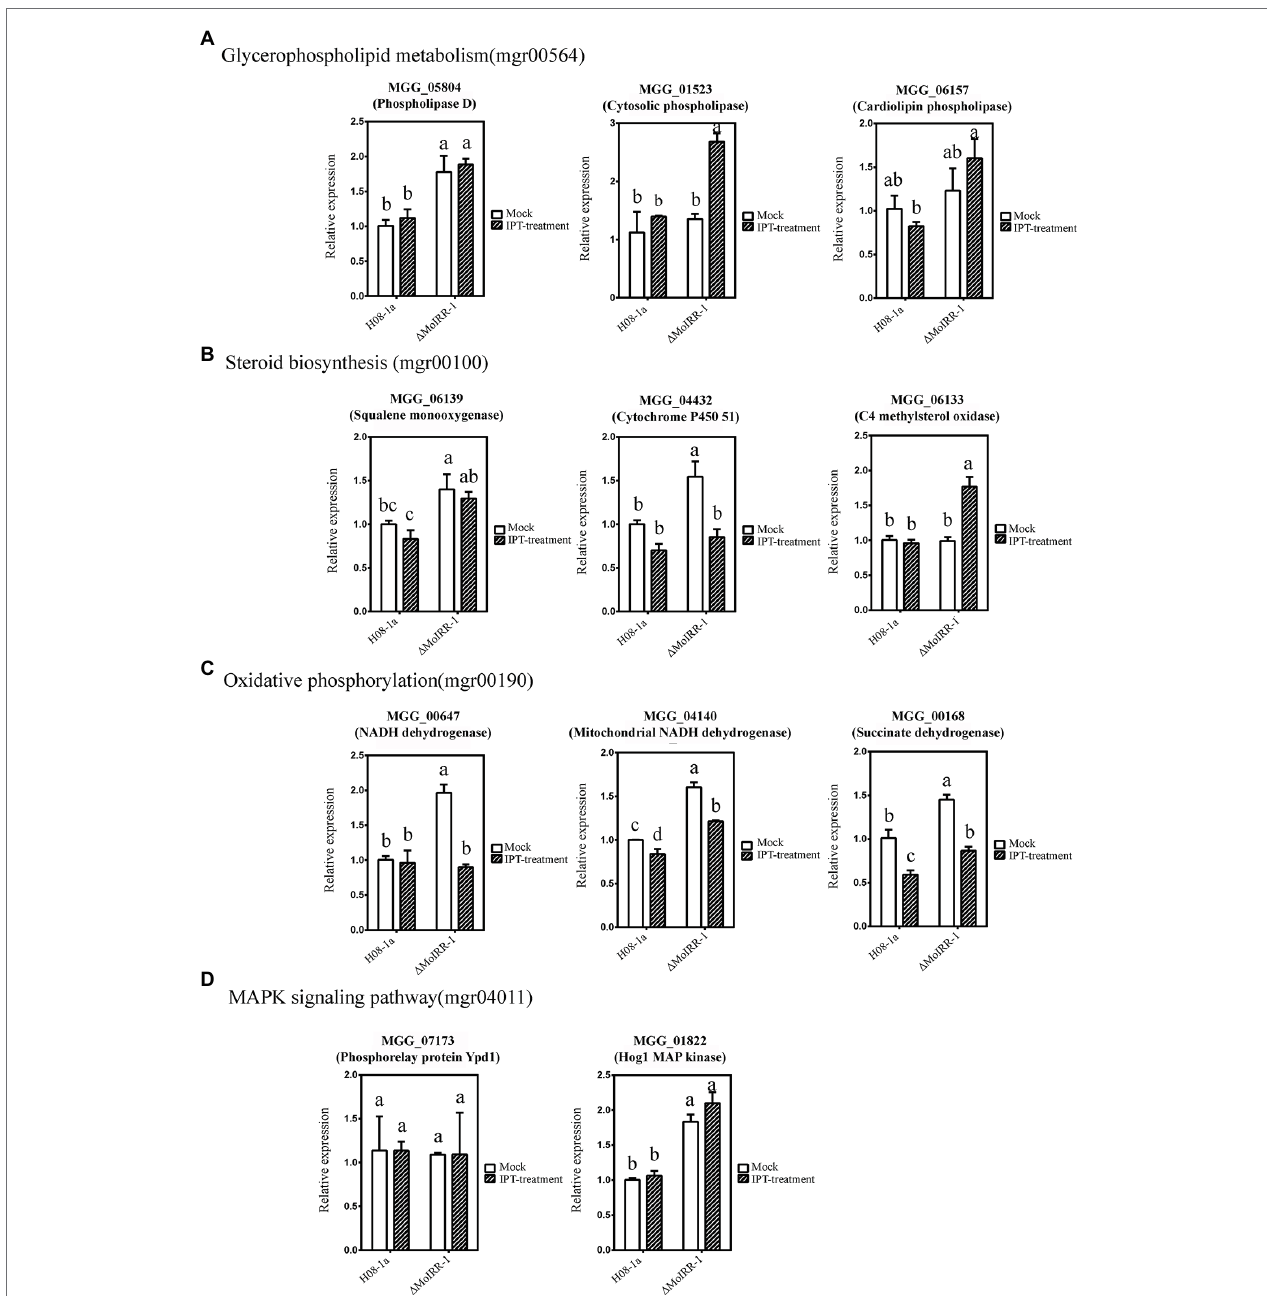
FIGURE 4 | Validation of resistance-related gene expression by using quantitative real-time PCR (qRT-PCR). (A) Three genes were mapped in the glycerophospholipid metabolism pathway (mgr00564) reported being associated with IPT-inhibited phosphatidyl-choline biosynthesis. MGG_05804 annotated as phospholipase D was expressed significantly higher in Δ MoIRR-1 but did not induce by 5 μ g/ml IPT treatment. Mycelia of H08-1a and Δ MoIRR-1 were inoculated into 40 ml PDB liquid medium separately and incubated at 27 ° C for 72 h with continuous shaking at 150 rpm. RNAs of mock samples were extracted from 4 h of acetone-treated cultures. RNAs of IPT-treatment samples were extracted from 4 h of 5 μ g/ml IPT-treated cultures. Beta-tubulin was used as the reference gene in qRT-PCR. (B) Three genes were mapped in the steroid biosynthesis pathway (mgr00100) associated with DMI fungicide resistance. MGG_06139 annotated as squalene monooxygenase and MGG_04432 annotated as cytochrome P450 51 were expressed significantly higher in Δ MoIRR-1 but did not induce by 5 μ g/ml IPT treatment. (C) Three genes were mapped in the oxidative phosphorylation pathway (mgr00190) associated with SDHI fungicide resistance. MGG_00647 annotated as NADH dehydrogenase, MGG_04140 annotated as mitochondrial NADH dehydrogenase, and MGG_00168 annotated as succinate dehydrogenase were expressed significantly higher in Δ MoIRR-1 but did not induce by 5 μ g/ml IPT treatment. (D) Two genes were mapped in the Hog1 MAPK pathway (mgr04011), and their deletion was reported to confer resistance to FLU. MGG_01822 annotated as Hog1 MAP kinase was also expressed significantly higher in Δ MoIRR-1 but did not induce by 5 μ g/ml IPT treatment. Different letters were calculated based on the replicates of treatments with Duncan test analysis indicate statistically significant differences ( p =